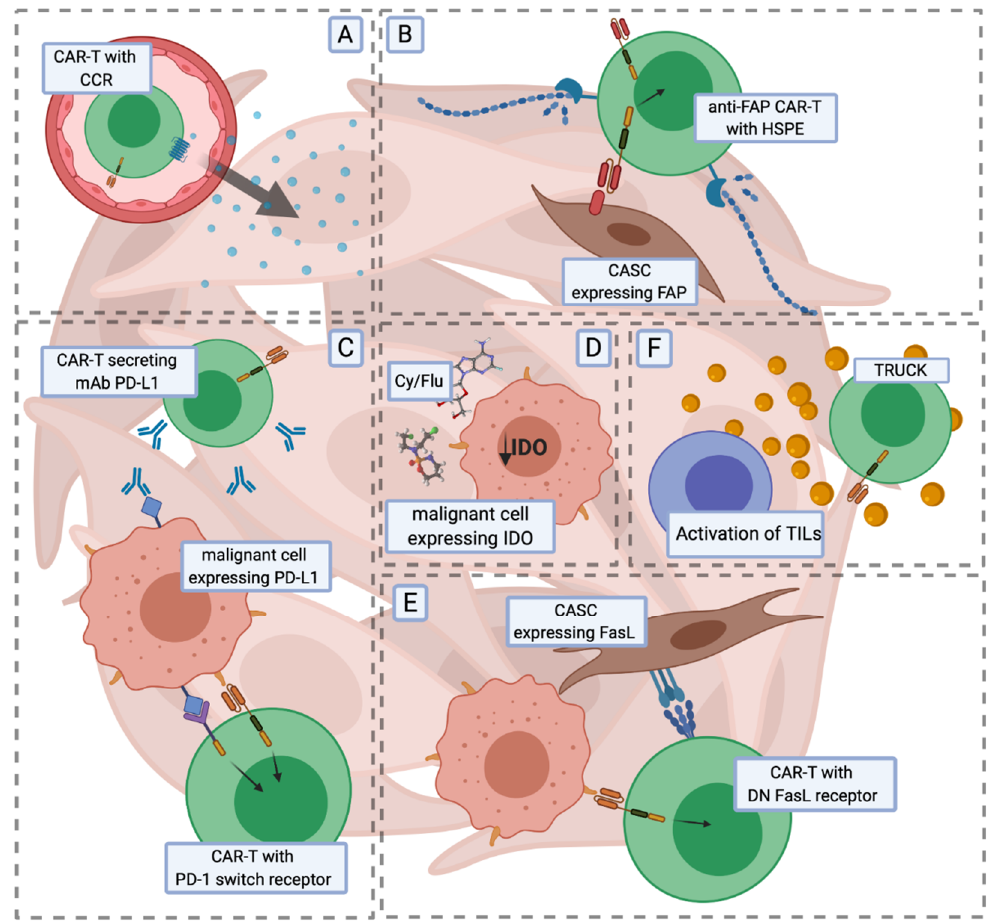
Figure 3. Examples of preclinical concepts supporting CAR-T cell anti-tumour activity in solid tumours. The effective eradication of solid tumours by CAR-T cells is jeopardised by impaired trafficking and infiltration into the tumour mass ( A,B ), competition with inhibitory signals ( C ) and reduced survival within the TME. ( A ) CAR-T cells additionally co-modified with a chemokine receptor (CCR) migrate towards and infiltrate solid masses in response to the chemokine gradient. ( B ) Forced expression of heparanase (HSPE) and redirection of CAR-T cells against fibroblast activation protein (FAP) further enhances the infiltration of solid masses. Blocking inhibitory molecules, such as PD-L1, by CAR-T cells secreting antibodies ( C , top) or modified with switch receptors ( C , bottom) providing activation signals leads to increased anticancer efficacy of the therapy. ( D ) Preconditional therapy with cyclophosphamide and fludarabine (Cy/Flu) decreases the expression level of IDO that inhibits T cell functions. ( E ) Modification of CAR-T cells with dominant-negative (DN) receptors for FasL leads to the resistance of CAR-T cells to proapoptotic signals present in the TME. ( F ) Armoured CARs (TRUCKs) engineered to secrete proinflammatory cytokines have enhanced anticancer efficacy and increase the activation of tumour infiltrating lymphocytes (TILs).